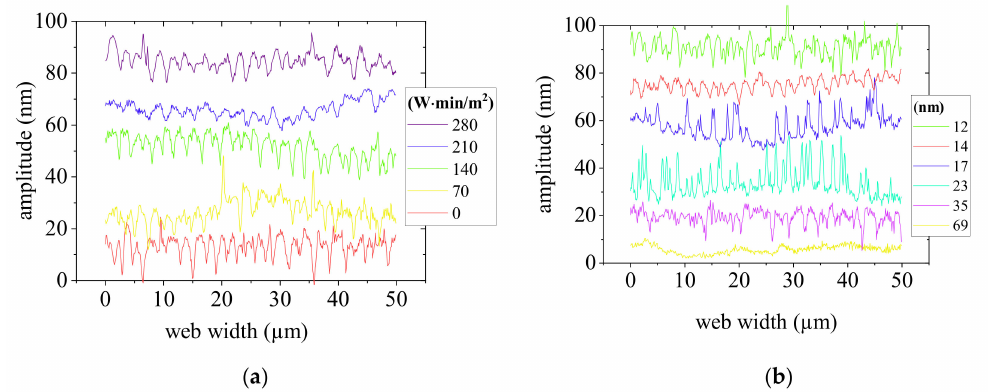
Figure 8. Atomic force microscopy cross sections of PET samples coated with aluminum and subjected to 20% strain for ( a ) di ff erent corona dosages of 0–280 W · min / m 2 and ( b ) di ff erent aluminum thicknesses of 12–69 nm. The troughs indicate cracks in the